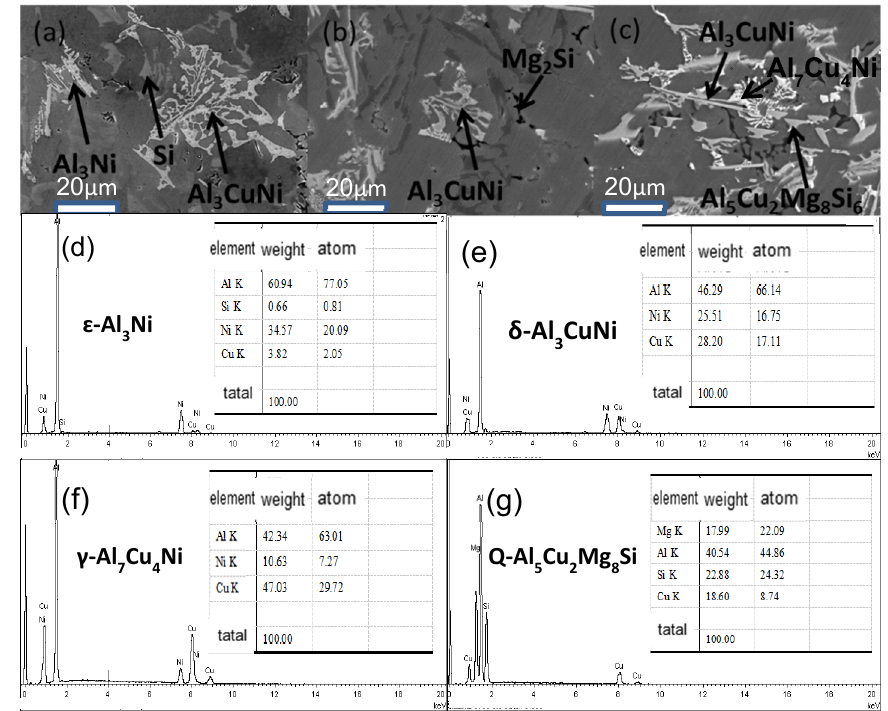
Figure 4. SEM analysis in the Al-13Si-4Cu-1Mg-2Ni alloy solidified with different cooling rates:( a ) 0.15 °C/s; ( b ) 1.5 °C/s; ( c ) 15°C/s; ( d ) EDS of ε-Al 3 Ni; ( e ) EDS of δ-Al 3 CuNi; ( f ) EDS of γ-Al 7 Cu 4 Ni; ( g ) EDS of Q-Al 5 Cu 2 Mg 8 Si 6.